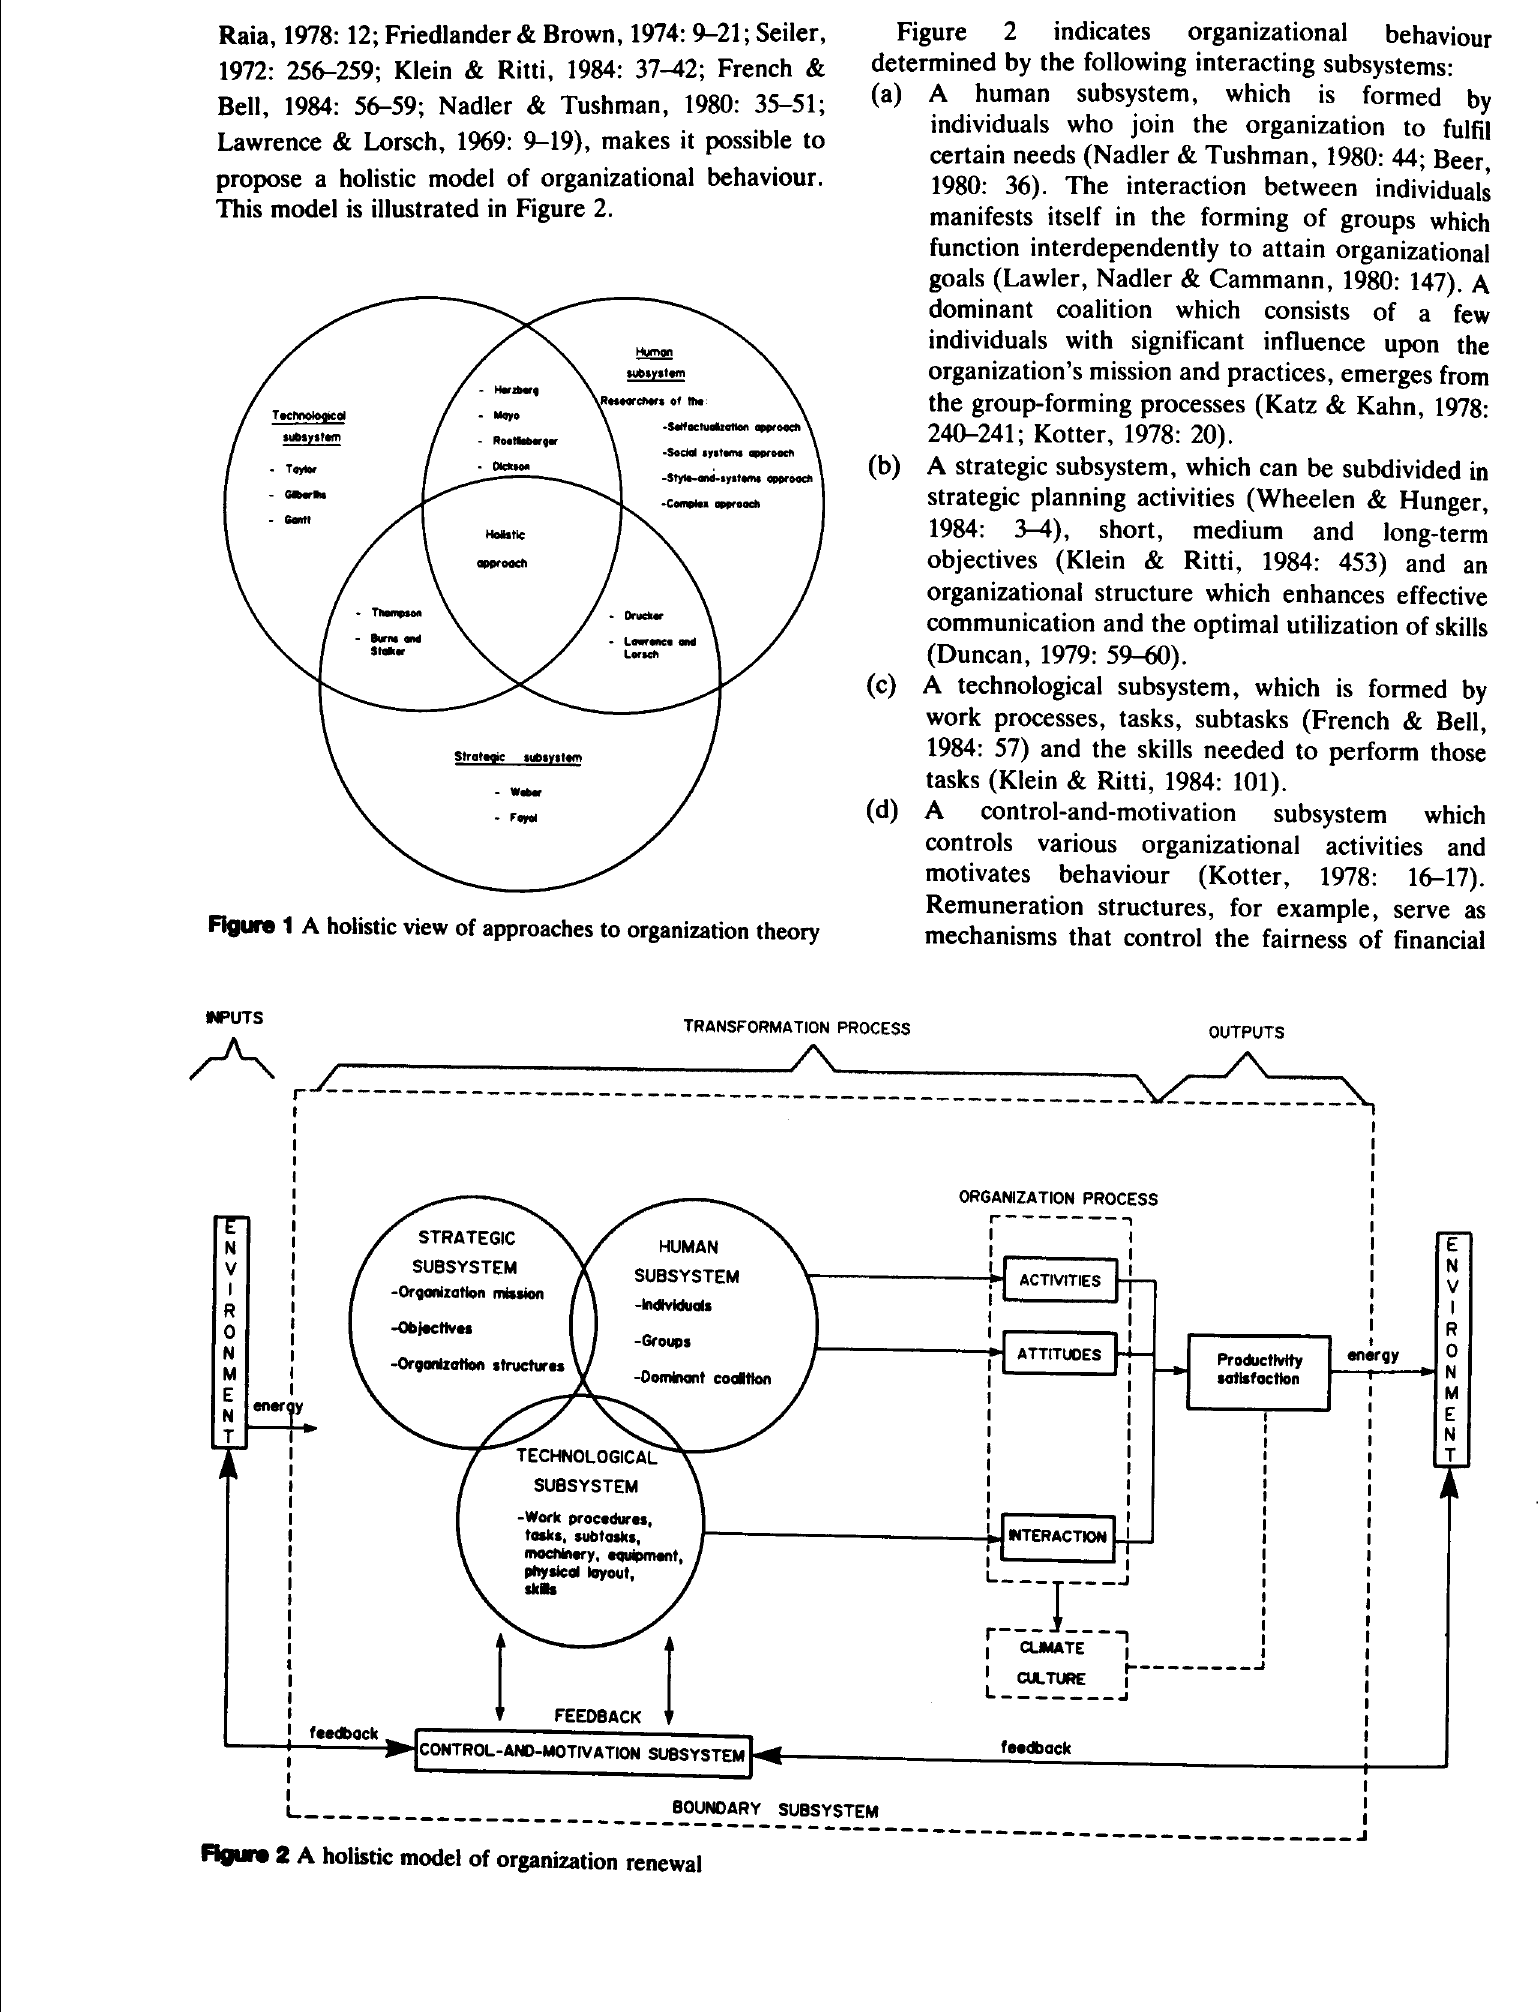
Figure 2 indicates organizational